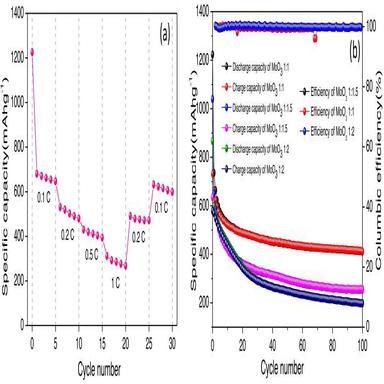
(a) Rate capability of MoO3 (1:1) nanoparticles (b) Cyclic performance and Columbic efficiency of MoO3 nanoparticles.